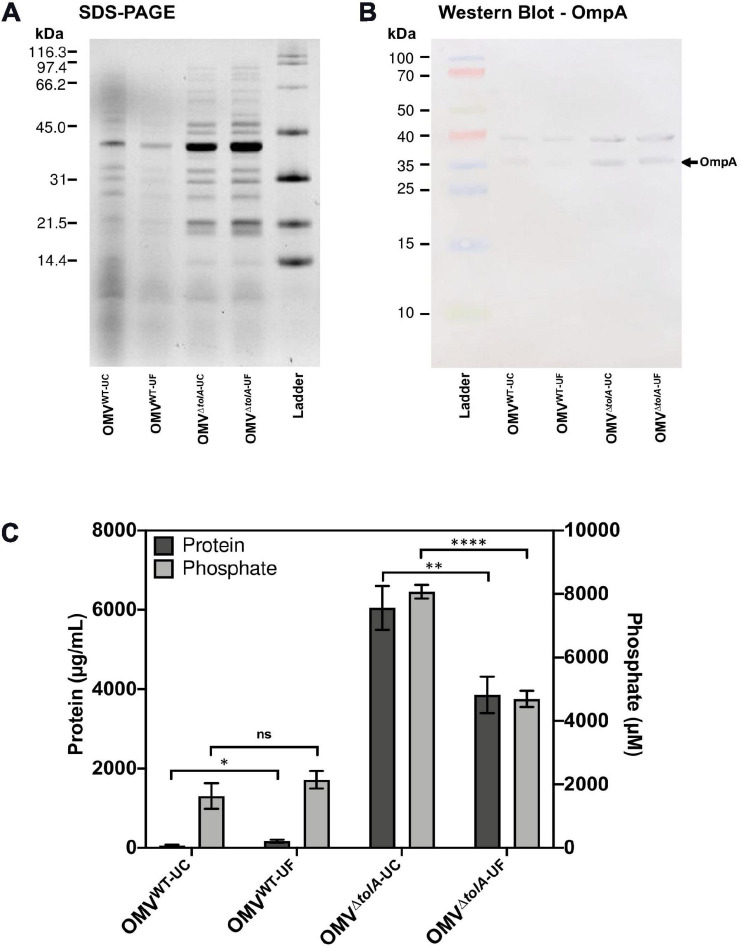
Protein and phosphorous profiles of isolated OMVs. (A) 12% acrylamide Tricine SDS-PAGE gel image of UC and UF OMV isolations for WT and ΔtolA E. coli strains detected with TCE. (B) Western blot of isolated OMV samples from WT and ΔtolA E. coli strains detected with anti-OmpA antibodies (1:25,000). (C) OMV sample total protein and total phosphorous content for each OMV isolation method. Values were obtained by BCA assay (protein) or malachite green assay (phosphate) and adjusted based on dilution factor and OD600 nm of the original culture. All data represent the mean of triplicate measurements, and error bars represent standard deviation. Significant differences between WT and ΔtolA samples or between UC and UF samples were determined using the Mann–Whitney U test at p-values of <0.05 (*), <0.005 (**), <0.00005 (****).